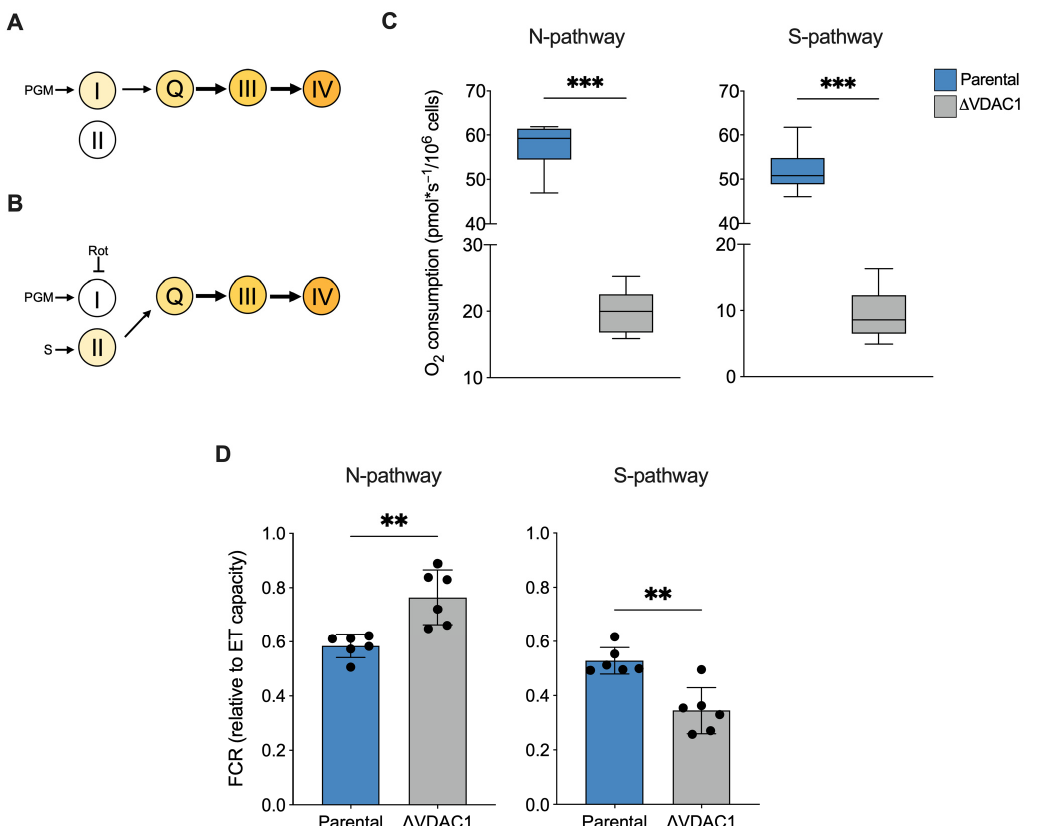
Figure 5. Analysis of N- and S-pathways in HAP1 cells. ( A , B ) Schematization of ET chain activity in our experimental HRR setup. Activation of complex III via Q-junction can occur exclusively by complex I or II, precisely by stimulating complex I with NADH-linked substrates and in the absence of succinate (N-pathway, A ) or by stimulating complex II with succinate upon inhibition of complex I with rotenone (S-pathway, B ). P—pyruvate; M—malate; G—glutamate; S—succinate; Rot—rotenone. ( C ) Quantitative analysis of the oxygen consumption rate of N- and S-pathway expressed as pmol/second per million cells. A significant reduction of oxygen consumption was observed in each state for Δ VDAC1 cells in comparison to parental. ( D ) FCRs calculated for N- and S-pathways revealed an increasement of N- over the S-pathway in Δ VDAC1 cells. Data are shown as median ( C ) or means ( D ) ± SEM of n = 6 independent experiments and statistically analyzed by unpaired t -test, ** p < 0.01 and *** p < 0.001.